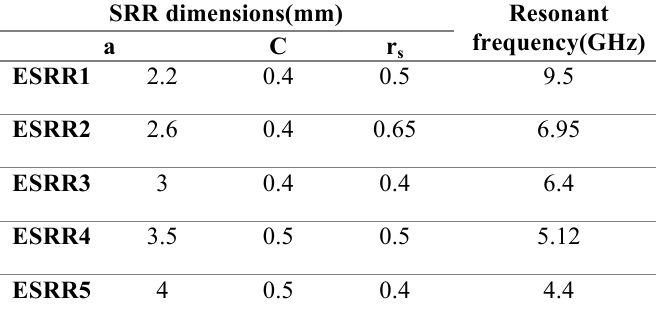
Table 2: Resonant frequencies of ESRRs for different a, c and r values. s